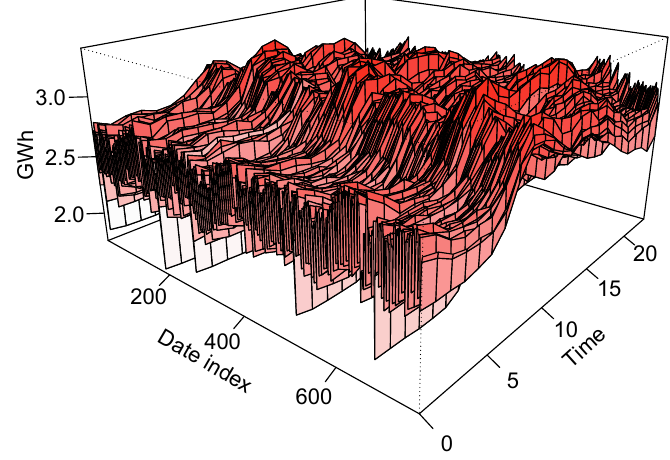
Figure 14. An example of the aggregated daily and yearly load pattern.